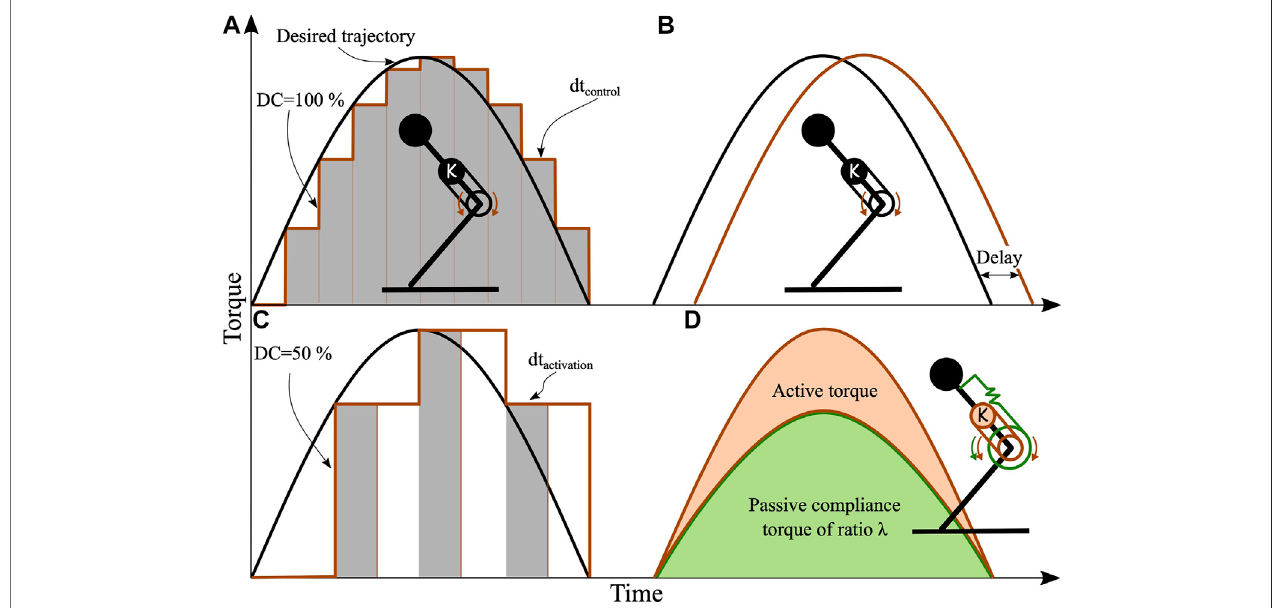
FIGURE 2 | Knee motor command for different combinations of control frequency, duty cycle, and sensorimotor delay. (A) A 100% duty cycle at low control frequency. (B) A set sensorimotor delay between the desired knee output torque, and the commanded output torque. (C) A 50% duty cycle. (D) An example for a compliance ratio of λ passive ≈ 0 . 75 is shown. The mechanical knee spring produces three quarter ofthe total knee torque (green). The knee actuator is programmed as a virtual spring producing the remaining torque (brown).